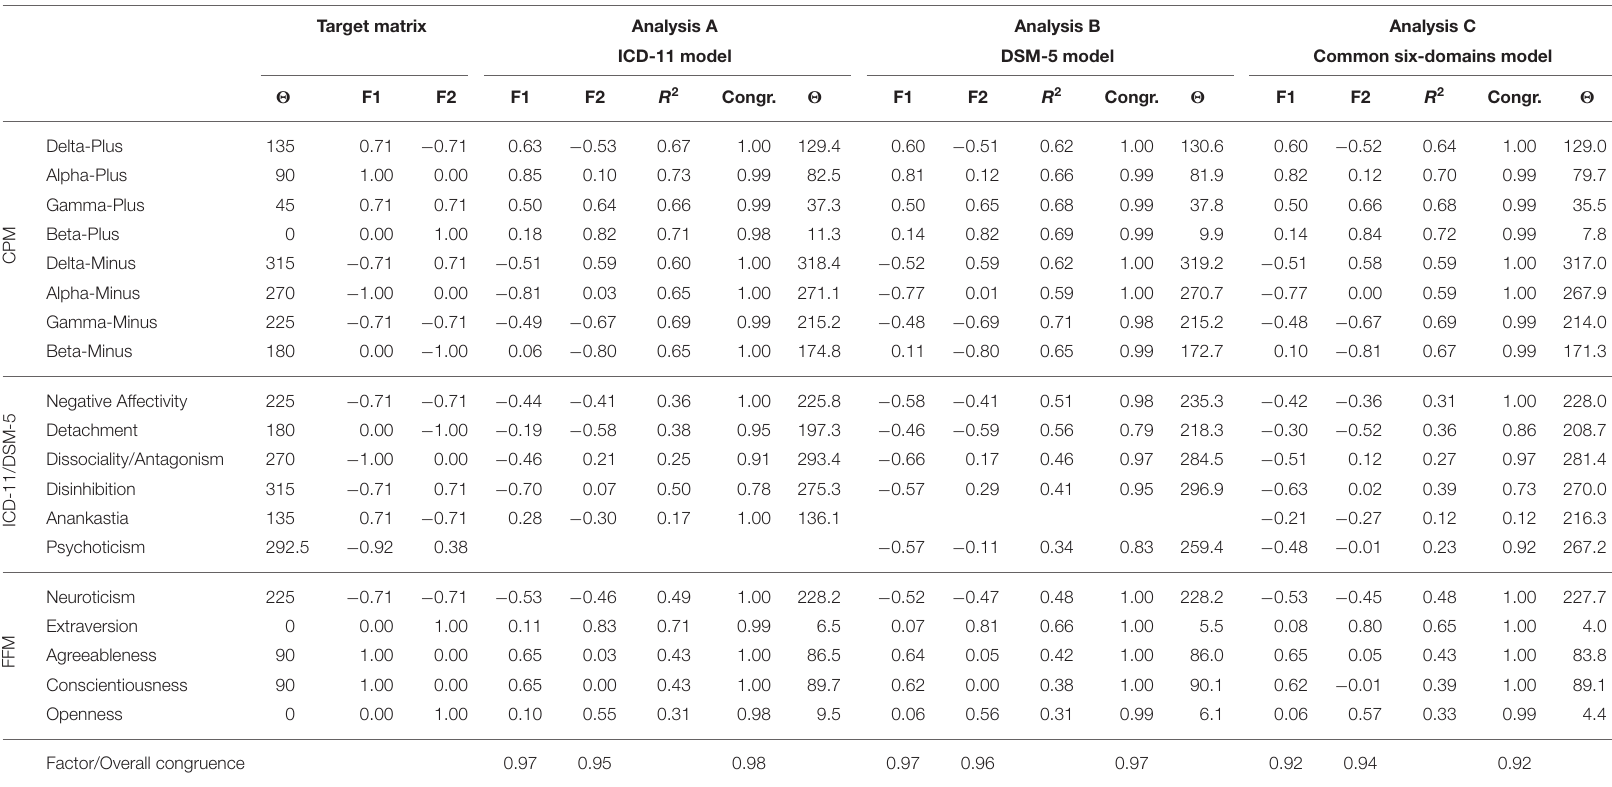
TABLE 4 | Target and obtained factor matrices with corresponding CPM angles, explained variances, and congruence coefficients for comparing target and obtained factor loadings of CPM metatraits, ICD-11 and DSM-5 psychopathological and FFM normal trait-domains in three analyses conducted in Study 1 ( N = 242).